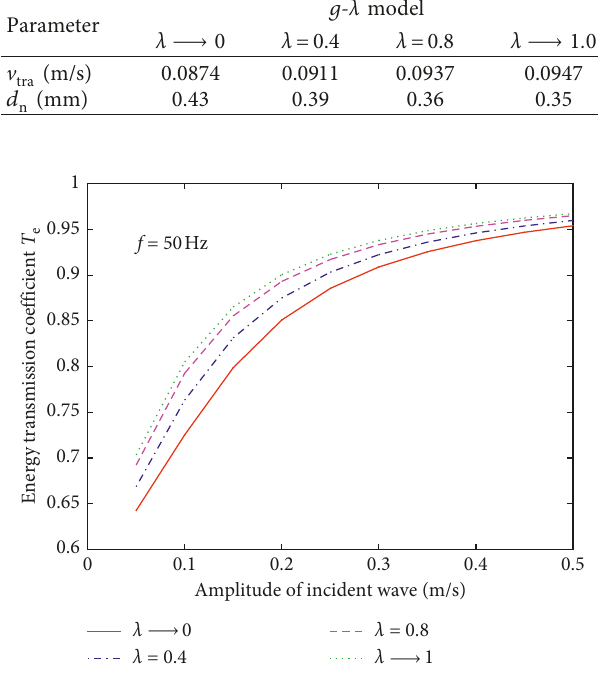
Figure 4: An incident P-wave pulse ( v int ) and the resulting transmitted pulse ( v tra ) across a single joint in terms of different constitutive models ( A 0 0.1m/s and f 50Hz). (cid:31) (cid:31)